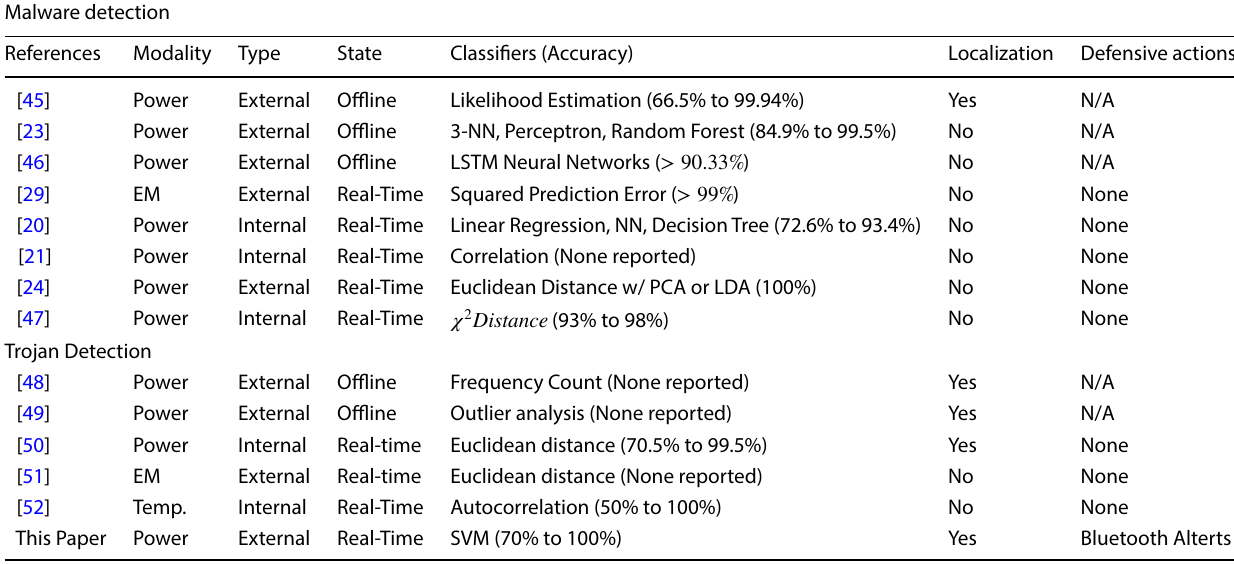
Table 4 Comparison of related work in side-channel based anomaly, malware, and hardware Trojan detection Malware